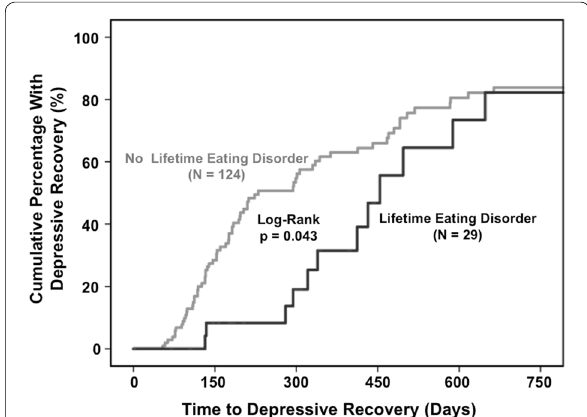
Fig. 1 History of eating disorder associated with delayed depressive recovery in bipolar disorder. Two-year survival curves for depressive recovery in depressed bipolar disorder patients indicated significantly delayed depressive recovery in patients with ( N 29, black line on = right ) vs. without ( N 124, gray line on left ) lifetime eating disorder = (Log-Rank p 0.043). Lifetime eating disorder was also significantly = associated with delayed depressive recovery using Cox Proportional Hazard analysis [Hazard Ratio (HR) 0.54 (95% Confidence Interval = (CI) 0.29–0.99), p 0.047]. No assessed demographic (not even = = gender) or clinical parameter significantly mediated delayed depres- sive recovery in patients with vs. without lifetime eating